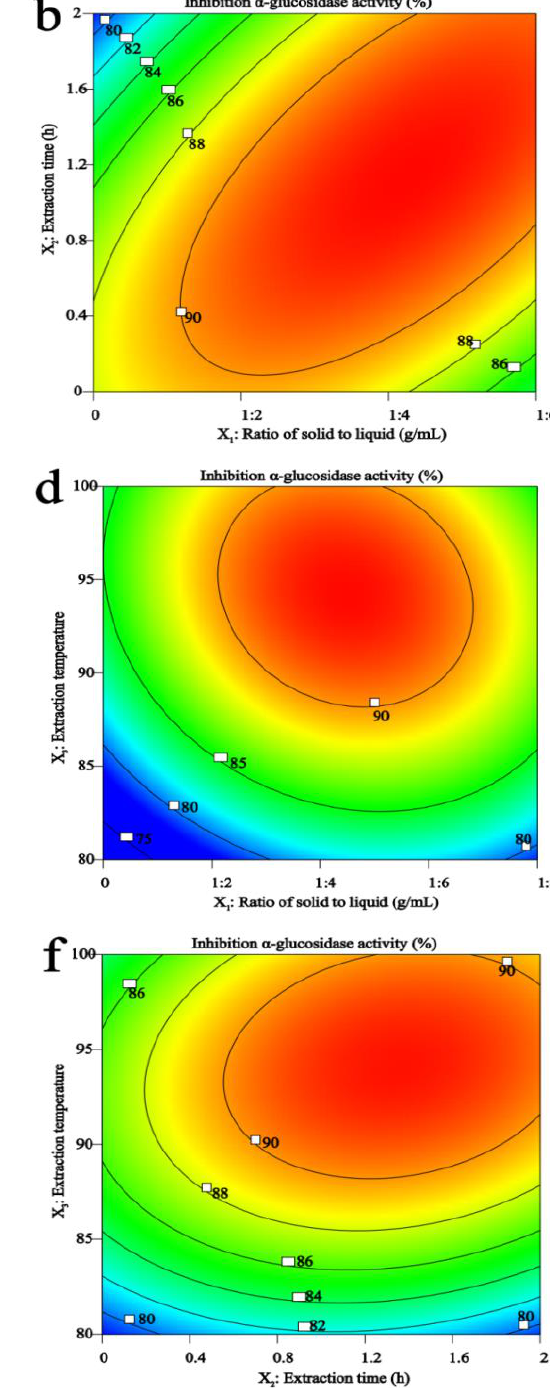
Figure 3. Effects of the solid-liquid ratio, time, and temperature on MAP-2 inhibition effect of α -glucosidase activity. Effects of different extraction time and solid-liquid ratios ( a , b ), extraction temperatures and solid-liquid ratios ( c , d ), extraction temperatures and extraction time ( e , f ) on MAP-2 inhibition effect of α -glucosidase activity.